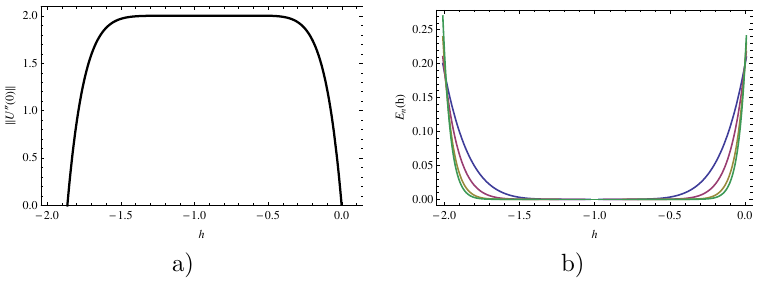
Figure 2. The h -curve ( a ) and squared residual E n ( h ) ( b ) for n = 3 , 5 , 8 , 10 (the successive curves from the top)